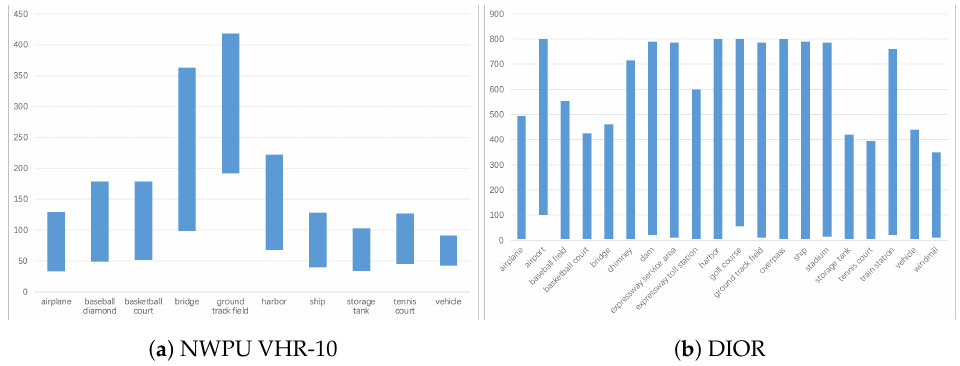
Figure 1. Object size (pixel) range per class in NWPU VHR-10 and